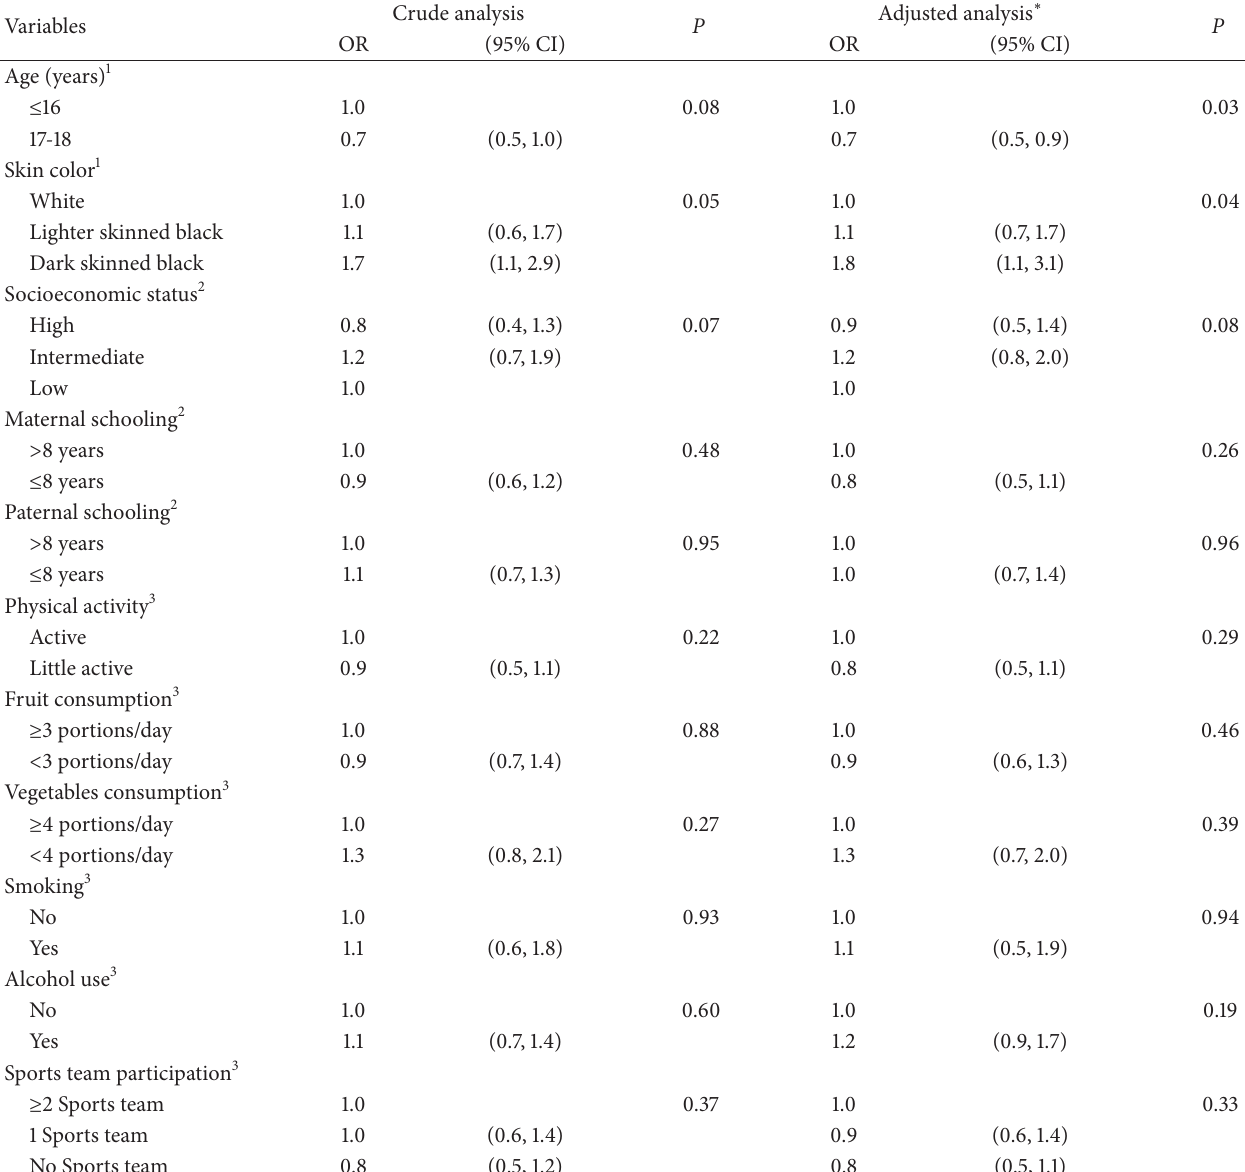
Table 4: Estimated odds ratios and 95% confidence intervals in the association between excess television time and independent variables in